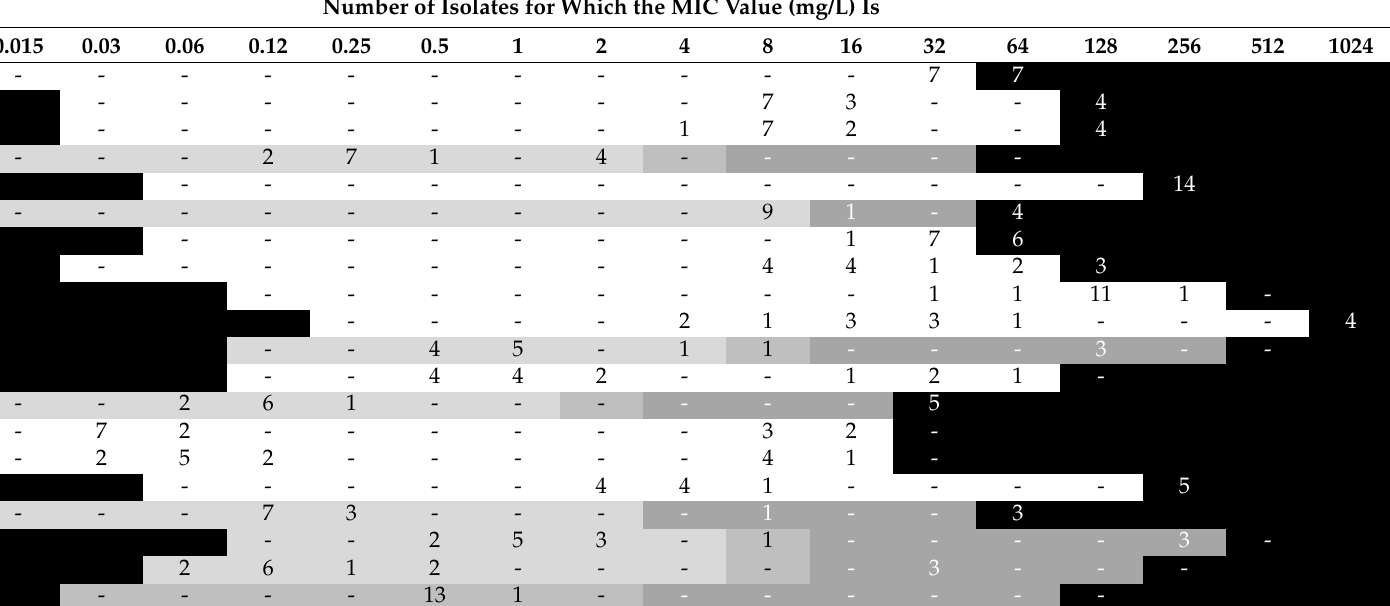
Table 5. Minimal inhibitory concentrations of the 14 canine and feline A. baumannii isolates. Antimicrobial Agent